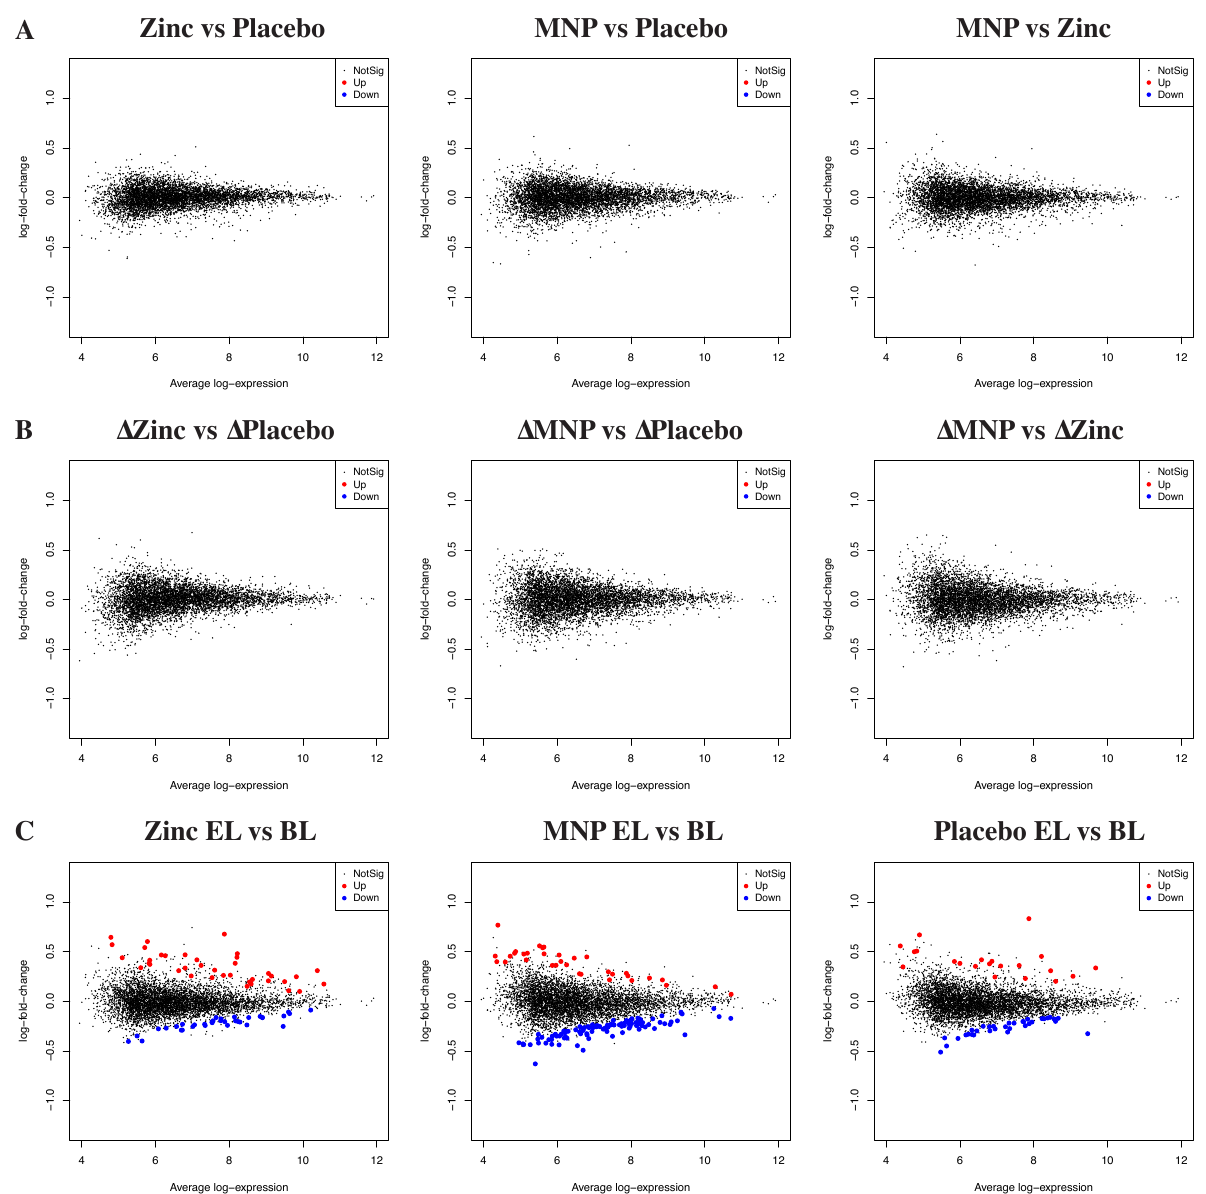
Figure 2. Comparative gene expression after zinc or MNP supplementation. RNA sequencing analysis of whole blood from participants treated with zinc tablets, MNPs or placebo powder showing ( A ) pairwise comparisons of differential gene expression between treatment arms at endline; ( B ) comparisons of the change in gene expression from baseline to endline between treatment arms; and ( C ) change in gene expression from baseline to endline within each treatment arm. Red = gene significantly upregulated. Blue = gene significantly downregulated. BL—baseline. EL—endline. Zinc—zinc 10 mg dispersible tablets; MNPs—14-micronutrient powders containing 10 mg zinc; placebo—placebo